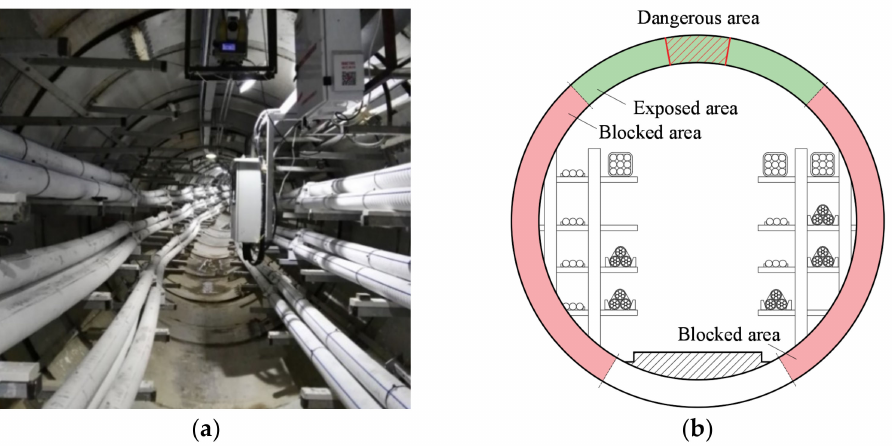
Figure 2. ( a ) The typical layout in a buried cable tunnel (Fujian, China) and ( b ) the sketch map of the cross section.